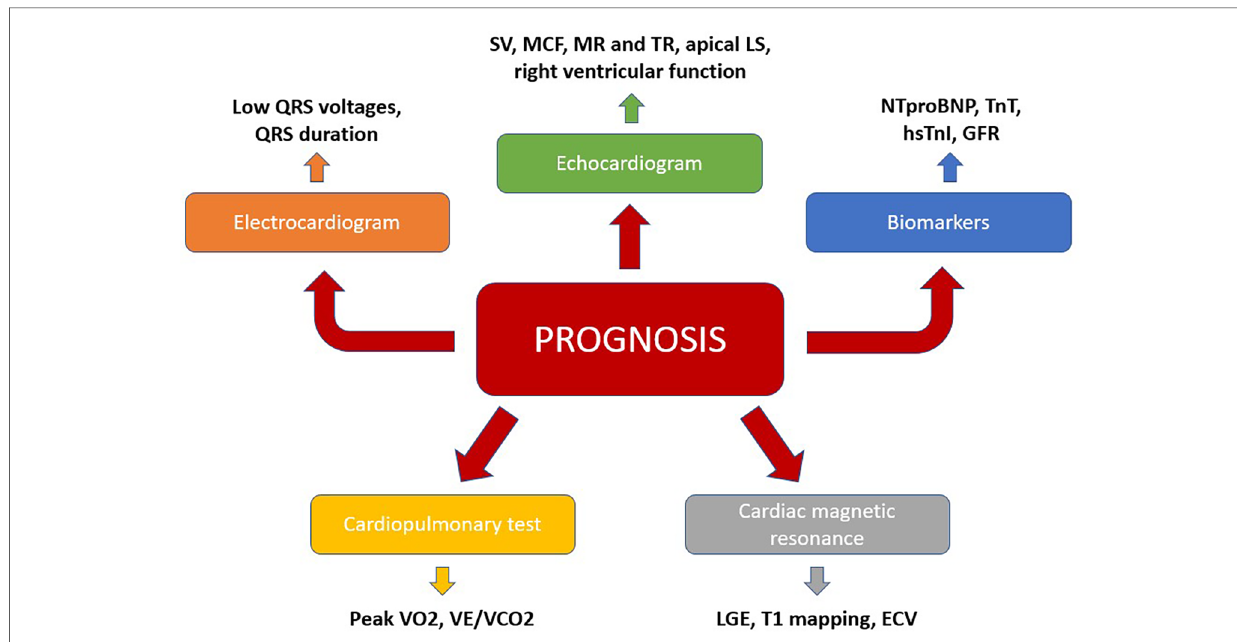
FIGURE 2 A multiparametric approach to predict prognosis in TTR-CA. ECV, extracellular volume; GLS, global longitudinal strain; GFR, glomerular fi ltration rate; LGE, late gadolinium enhancement; MR, mitral regurgitation; TR, tricuspid regurgitation; VCO 2 , carbon dioxide output; VE, minute ventilation; VO 2 , maximum oxygen